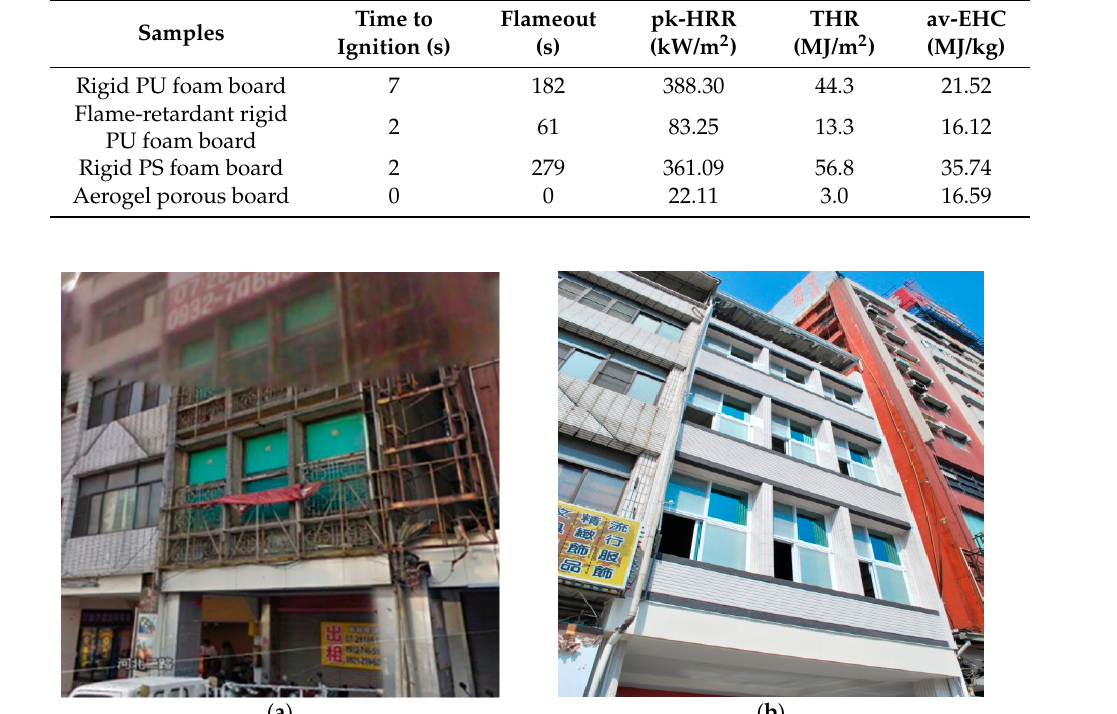
Figure 8. Street view of the case study building before ( a ) and after ( b ) retrofit. Table 3. Combustion parameters obtained from the cone calorimeter.